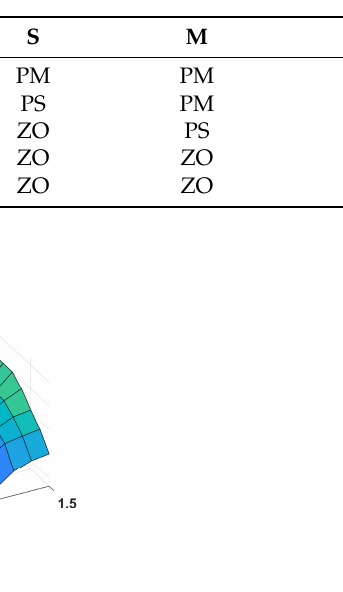
𝐾 = 12 . Higher potential energy provides greater assistance force. The simplified control block diagram of FAP proposed in this paper is shown in Fig-